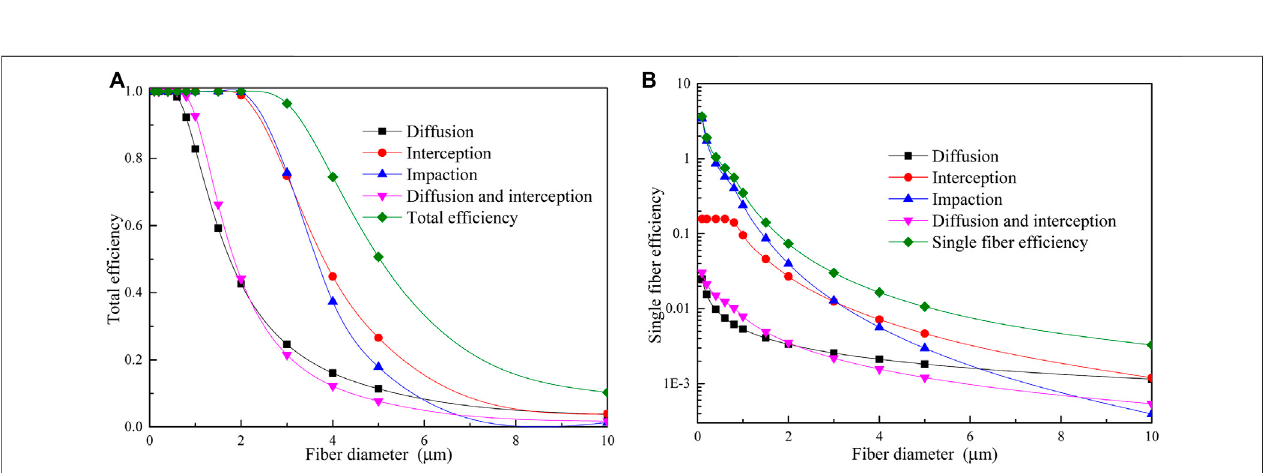
FIGURE 6 | Effect of fi ber diameter on fi ltration ef fi ciency: (A) Total fi lter ef fi ciency; (B) Single- fi ber ef fi ciency.